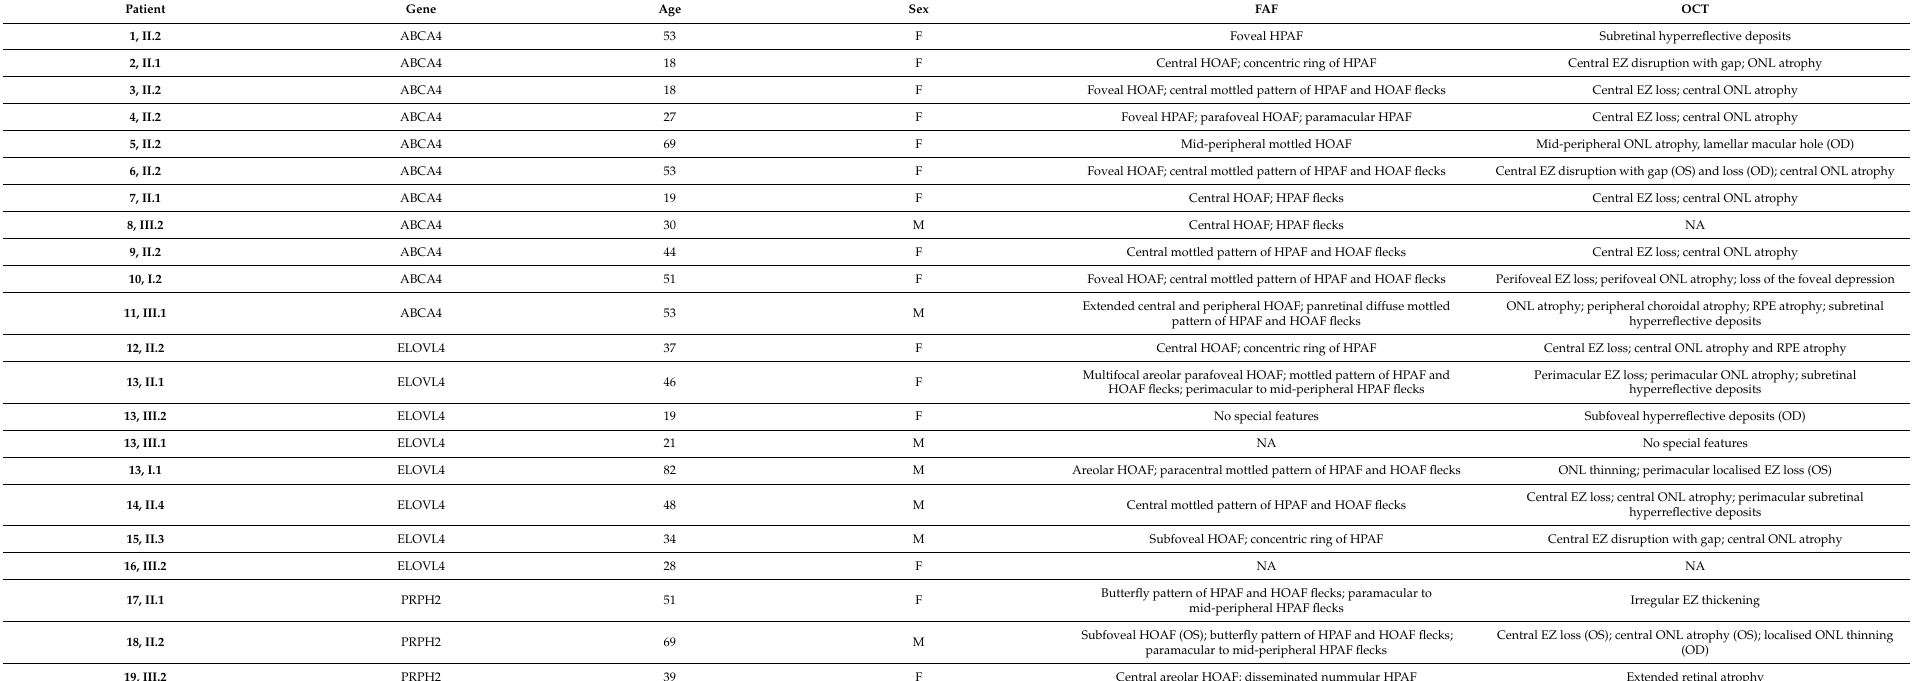
Table 2. Summary of fundus autofluorescence (FAF) and optical coherence tomography (OCT) findings. EZ, ellipsoid zone; FAF, fundus autofluorescence; HOAF, hypoautofluorescence; HPAF, hyperautofluorescence; NA, not available; OD: right eye; ONL, outer nuclear layer; OS, left